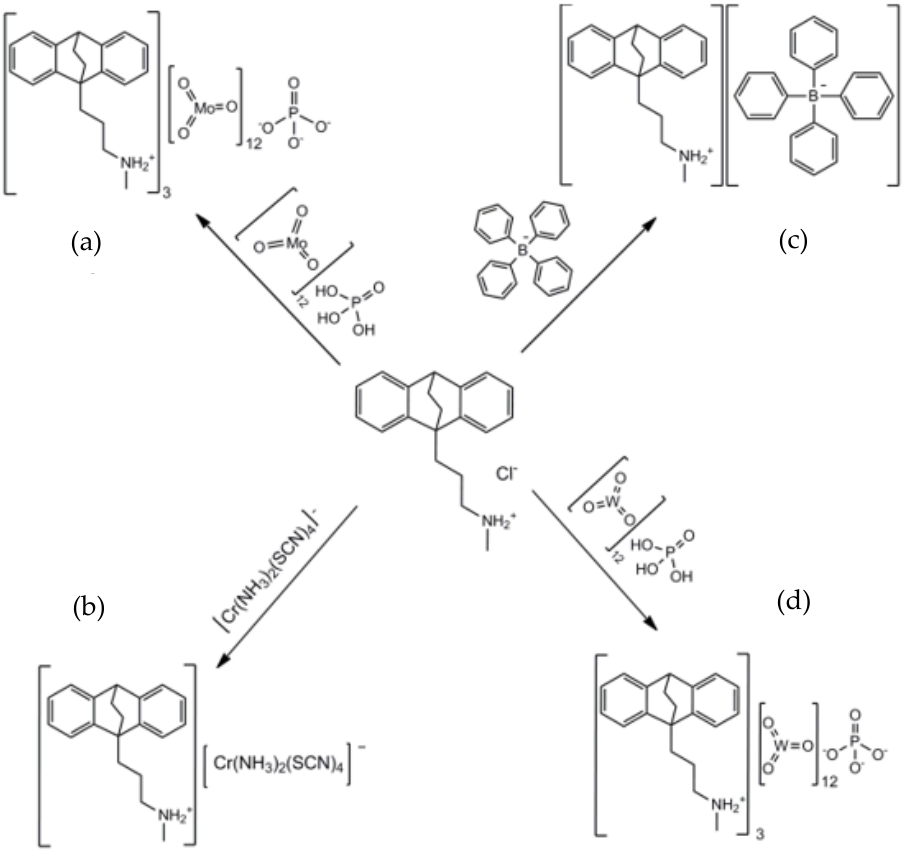
Figure 1. Proposed reaction between the MAP and different ion pairing agents to obtain ion- association complexes: ( a ) MAP 3 -PM; ( b ) MAP-R; ( c ) MAP-TPB; ( d ) MAP 3